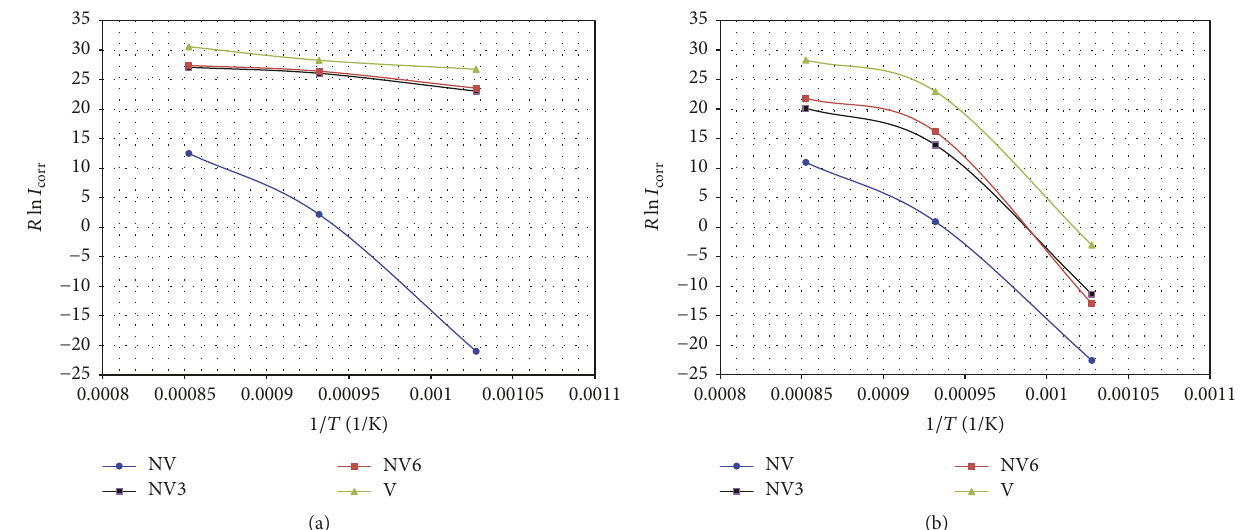
Figure 9: 𝑅 ln (𝐼 corr ) - 1/𝑇 relationship for Ni evaluated in vanadium salts. (a) Data from the potentiodynamic polarization curves. (b) Data from LPR measurements.